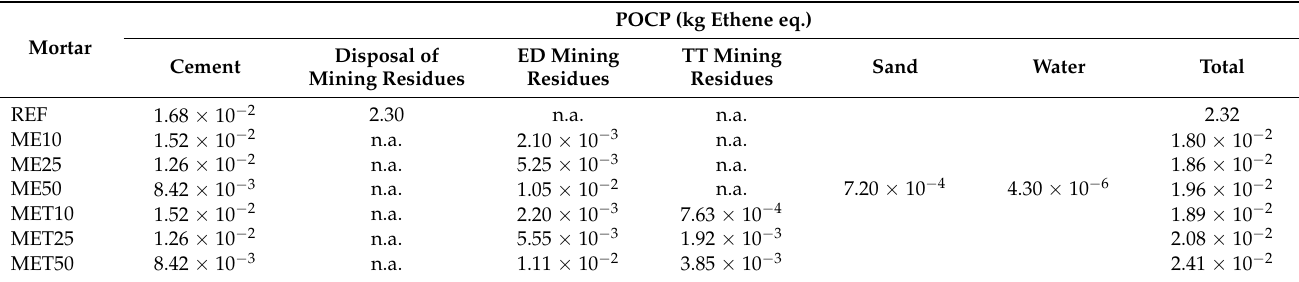
Table A4. Environmental impacts in the Photochemical Ozone Creation Potential category, from the production of 1 t of mortars with cement and treated mining residues as binder constituents.